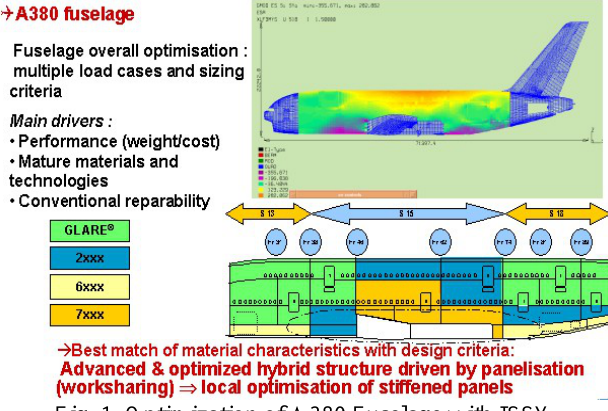
Fig. 1. Optimization of A380 Fuselage with